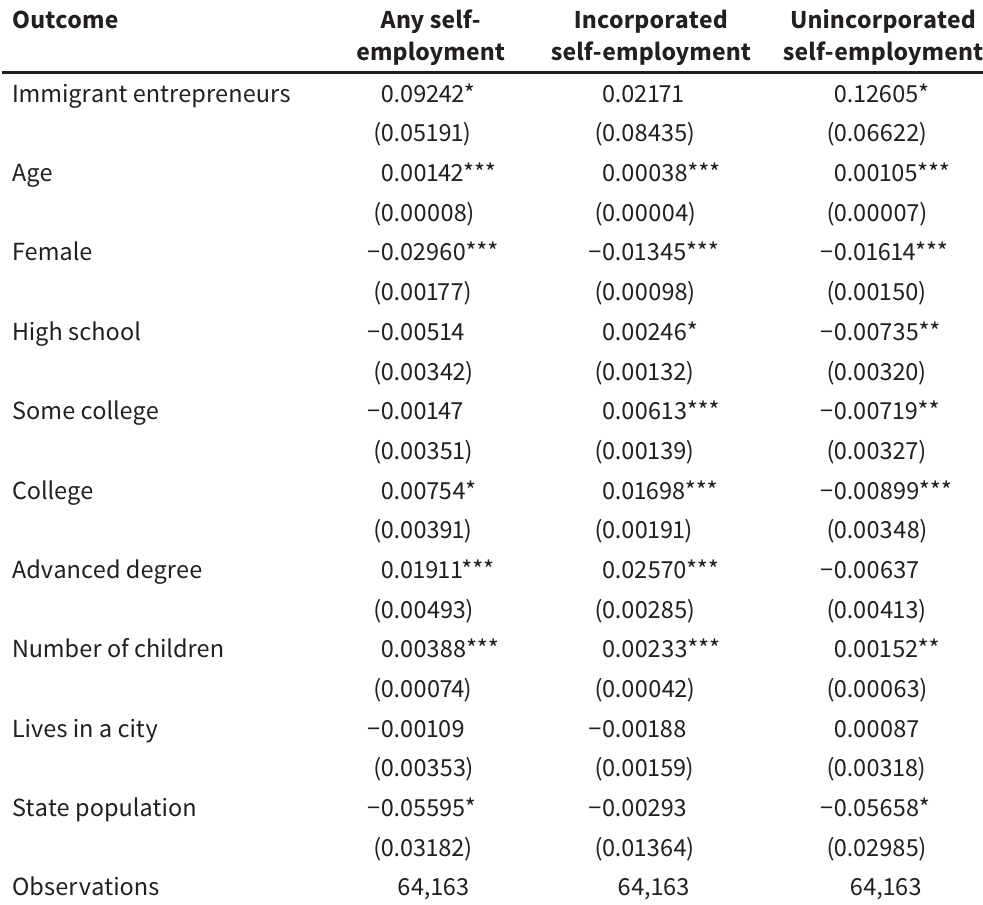
Heterogeneity in the Impact of Immigrant Entrepreneurs across Races of Natives: Second Stage Estimates for